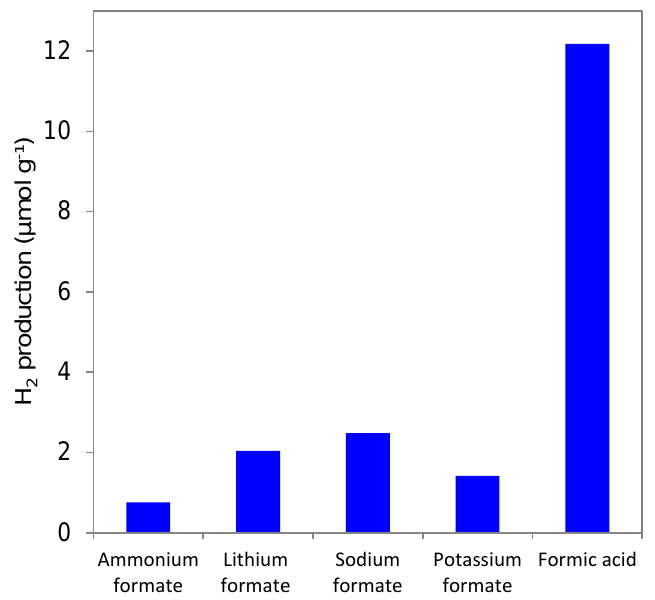
Figure 7. Effect of formate type on photocatalytic hydrogen production with TiO 2 with the aid of simultaneous Rh deposition from various formates (0.265 mol L − 1 ) and formic acid (1 wt%) solutions. TiO 2 , 50 mg; Rh, 1.25 ppm; reaction time, 3 h; reaction temperature, 50 °C.